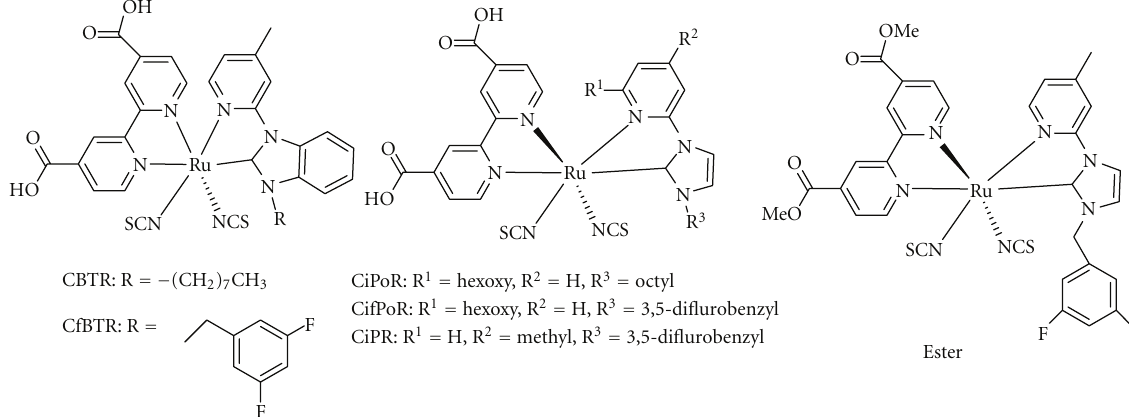
Figure 26: Molecular structure of the new sensitizers CBTR, CfBTR, CiPoR, CifPoR, CifPR, and ester (taken from [45, 46]).